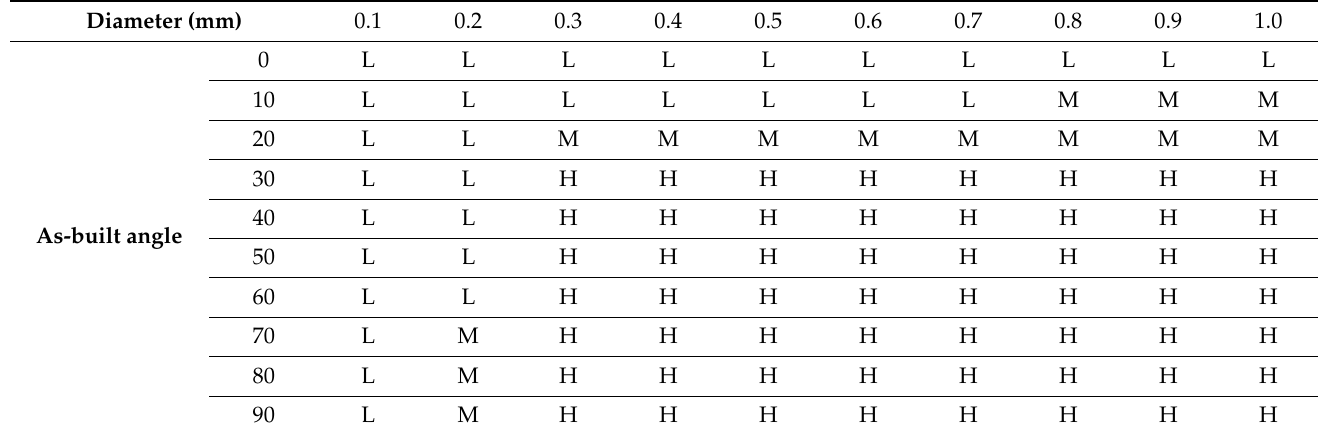
Table 2. Effect of micro-rod diameter and as-built angle on manufacturability: L averages unable to form, M averages a poor forming effect, and H averages a good forming